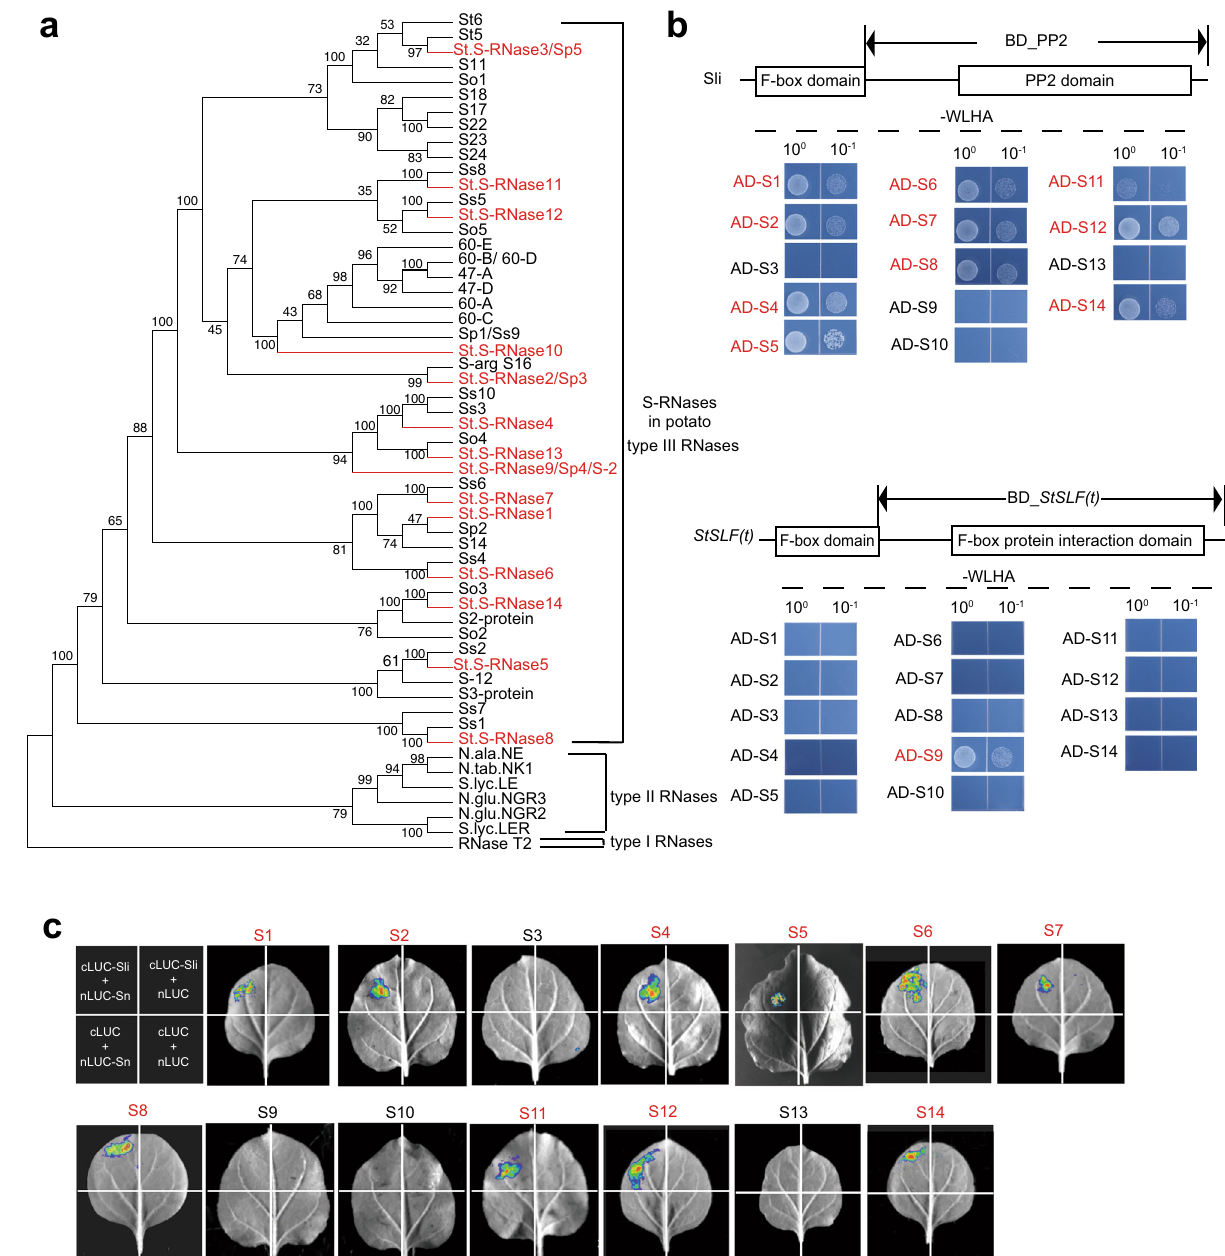
Fig. 3 Wide interactions between Sli and 14 types of potential StS-RNases. a A phylogenetic tree analysis of the potatoes S-RNases. StS-RNase1 – 14 are 14 types of S-RNases reported in this study (indicated in red), while the other 35 S-RNases were obtained from GenBank. b Yeast two-hybrid (Y2H) analysis of the interactions between 14 potential S-RNases and the PP2 domain of Sli (BD-PP2). The conserved domains of Sli are indicated by rectangles. The interactions between potential S-RNases and the full length of Sli are shown in Supplementary Fig. 6. The F-box protein interaction domain of a SLF gene ( RHC01H2G1617 ) was used as a negative control [BD-StSLF(t)]. WLHA, synthetic dropout media lacking tryptophan, leucine, histidine, and adenine. BD binding domain, AD activation domain. c The fi re fl y luciferase (LUC) complementation imaging assays of the interactions between the S-RNases and the PP2 domain of Sli. LUC signal was captured in the leaf area co-expressing the PP2 domain of Sli and each of the S-RNases (indicated in red), except for S3, S9, S10, and S13. Sn denote each type of the StS-RNase1 – 14, nLUC the N terminal of LUC protein, cLUC the C terminal of LUC protein. The experiments were repeated three times with similar